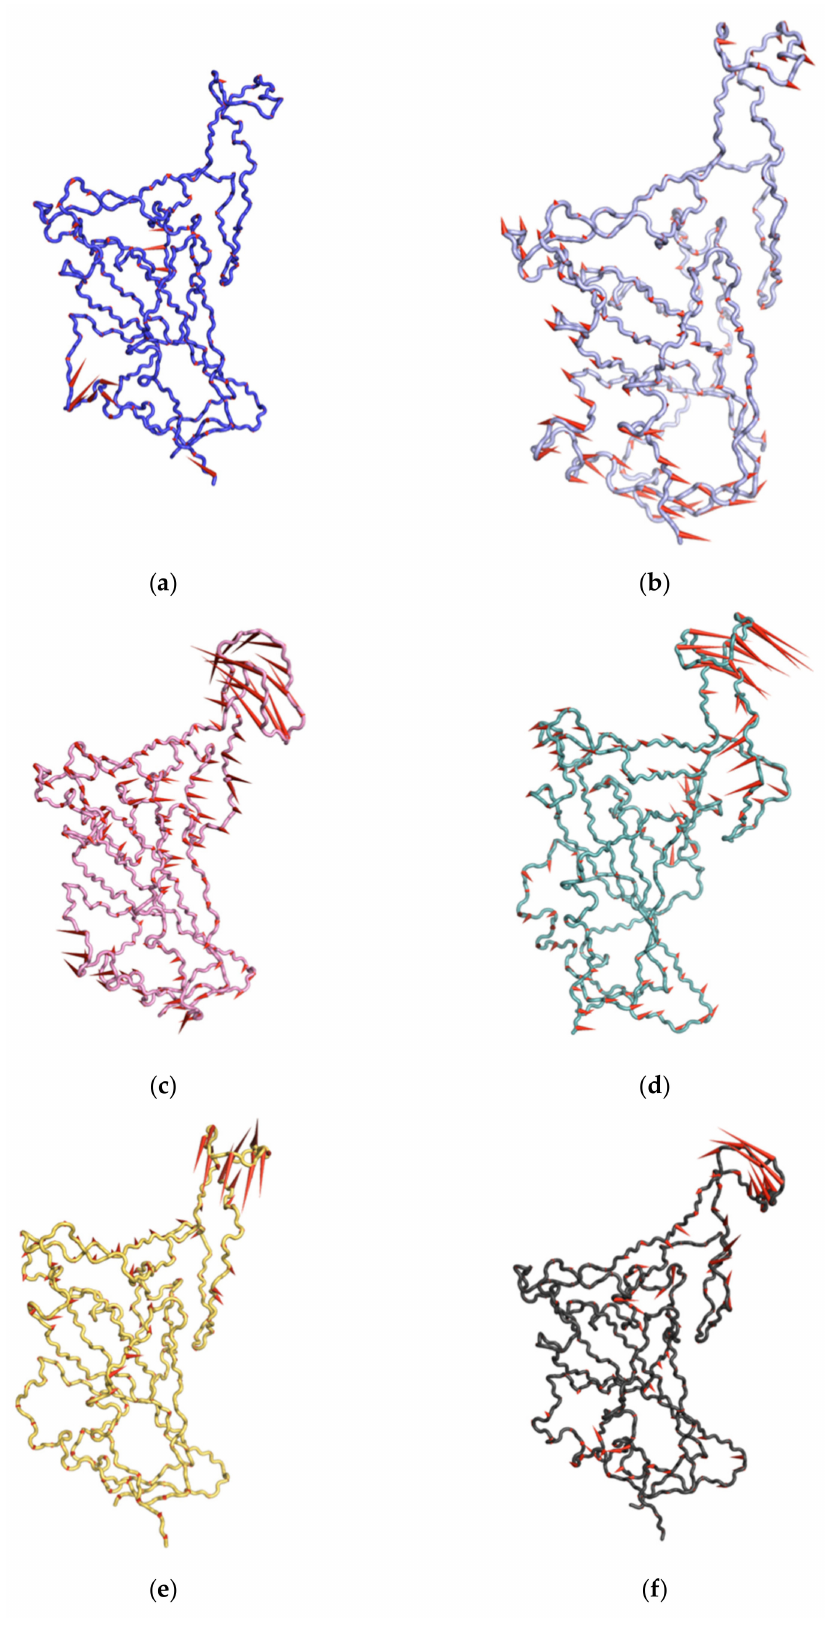
Figure 6. Porcupine plots showing the motion across the first principal component (PC) in WT RBD ( a ) and N501Y ( b ), L452R ( c ), S477N ( d ), N439K ( e ), and E484K ( f ) mutants. The arrows reflect the direction of the correlated motion and the extent of the